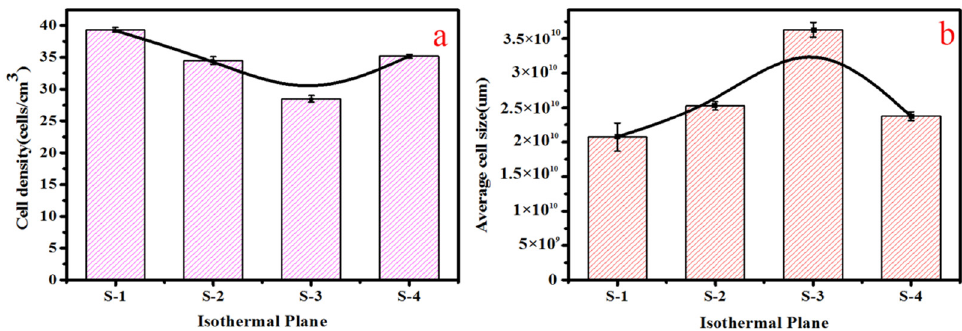
Figure 10: Parameters of the cell structure of di ff erent planes of PP foamed composites: ( a ) cell density and ( b ) average cell diameter.